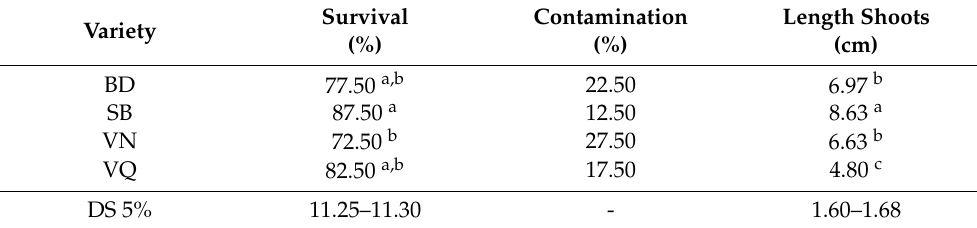
Table 7. Rate of survival after three weeks from initiation moment.